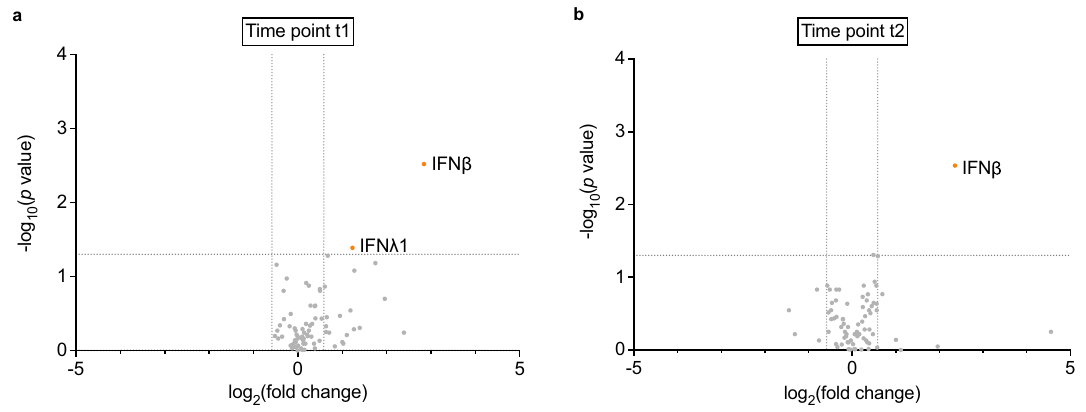
Figure 2. Volcano plot displaying biomarkers with a significant p value (y-axis) and fold change (early relapse/ late relapse, x-axis) between the early and late relapse groups. ( a ) Volcano plot at time point t1. Biomarkers with ≥ 1.5-fold-change (vertical dotted lines) and p value of < 0.05 (horizontal dotted line) are shown by orange– red dots. ( b ) Volcano plot at time point t2. The image was created using GraphPad Prism 9 (www. graph pad.